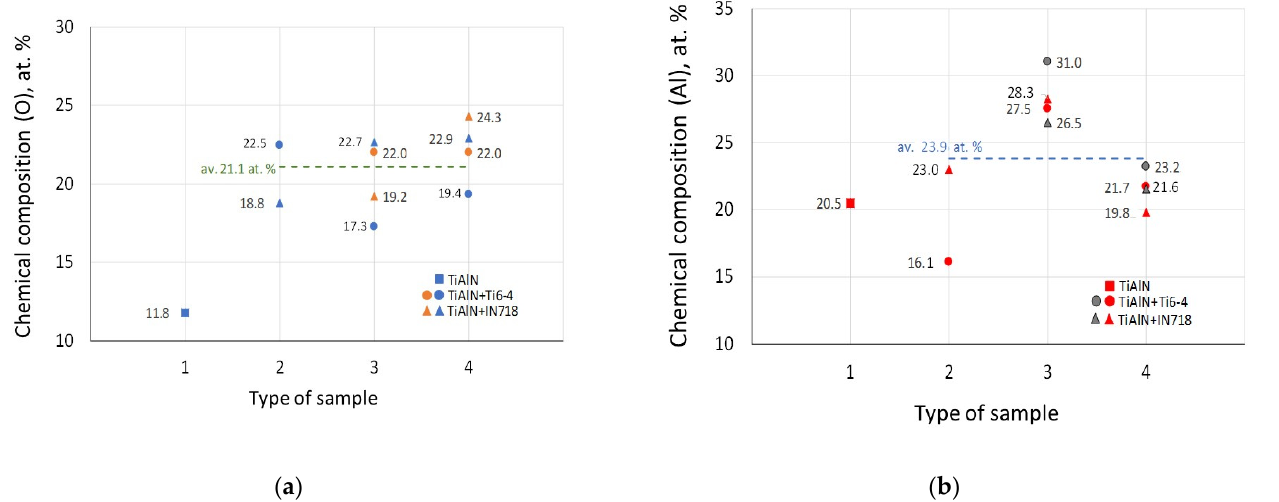
Figure 14. Comparison of oxidation conditions based on the at.% O ( a ) and Al ( b ) for different samples: 1, TiAlN; 2, diffusion couples; 3 and 4, rake and flank faces after machining with machining time of 0.5 min and 2 min (data specified in Tables 2, 3 and 5, respectively).